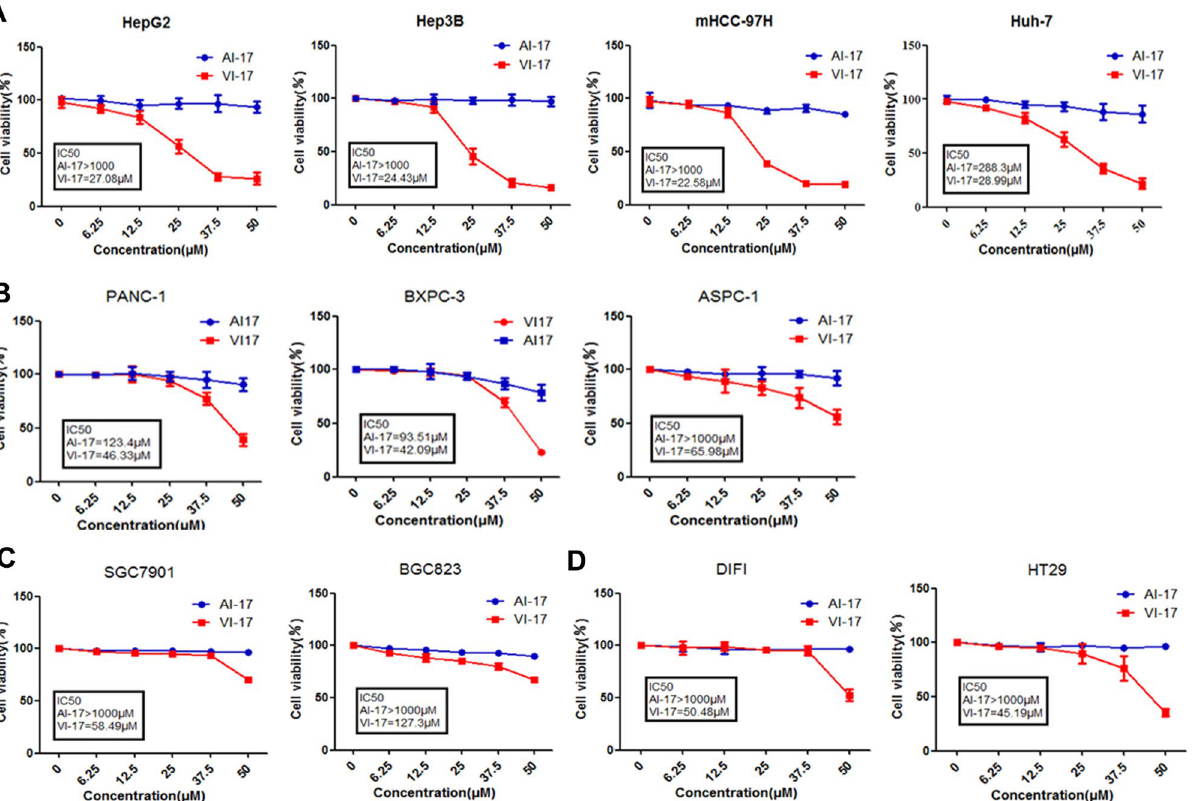
Figure 2. VI-17 was effective against multiple cancer cell lines in vitro. (A) MTT assays of the bioactivity of VI-17 against hepatoma cells. (B) MTT assays of the bioactivity of VI-17 against pancreatic cancer cells. (C) MTT assays of the bioactivity of VI-17 against gastric cancer cells. (D) MTT assays of the bioactivity of VI-17 against colonic cancer cells. Data are expressed as Mean ± SD of three independent experiments in